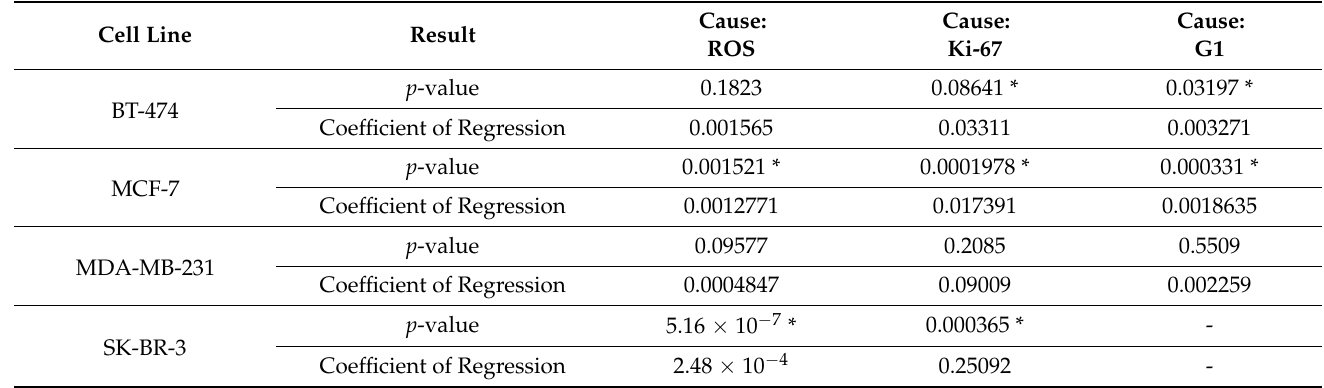
Table 4. p -values and coefficients of linear regression for all cell death models for cells treated for 3 min (* p <